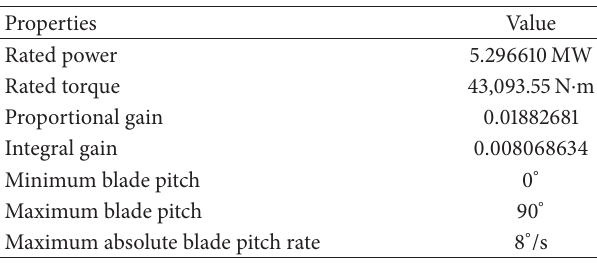
Table 3: Baseline pitch controller